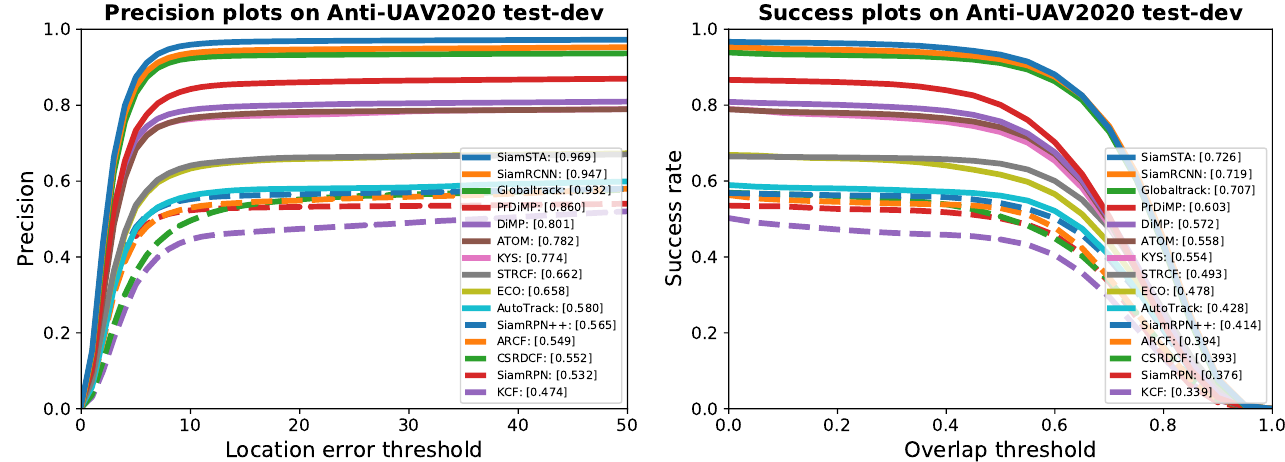
Figure 4. Precision and success plots of our SiamSTA and state-of-the-art trackers on the Anti- UAV2020 test-dev dataset. The mean precision and AUC scores are reported for each tracker. Best viewed in color and zoom.